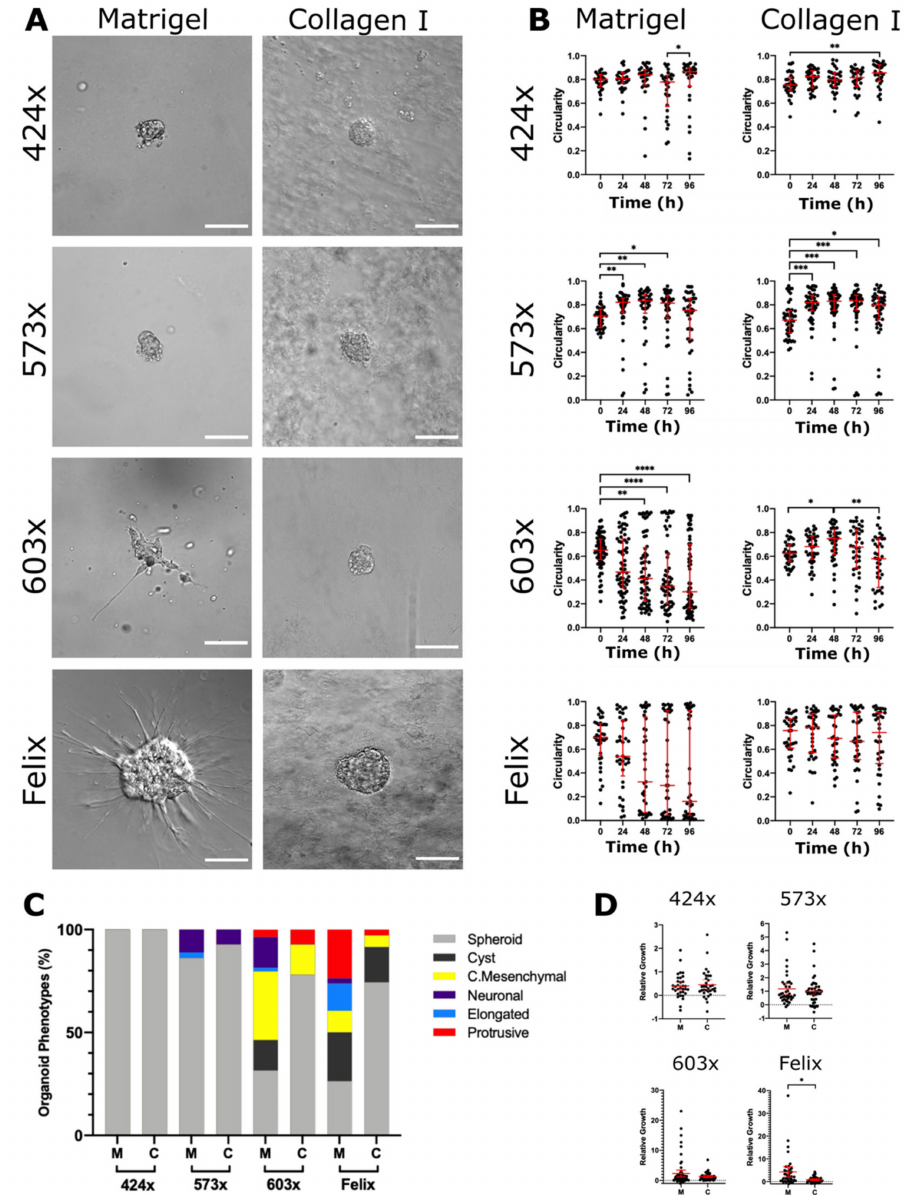
Figure 2. ECM microenvironments modulate the pattern of collective invasion and local dissemination in neuroblastoma cells. ( A ) Representative DIC images of organoids isolated from neuroblastoma PDXs and grown in 3D ECM cultures at 96 h. Based on morphology NB, organoids were classified as non-invasive (spheroid, cyst) or invasive (elongated, collective mesenchymal, neuronal or protrusive). For spheroid and cyst: DIC scale bars = 100 µ M; elongated scale bars = 150 µ M DIC. For other DIC images: scale bars = 200 µ M. ( B ) Organoid circularity was measured at 96 h in Matrigel and collagen (Kruskal–Wallis and Dunn’s post-hoc tests; horizontal bars represent median and interquartile range). ( C ) Bar charts represent phenotype classifications. ( D ) The relative growth of organoids was calculated by dividing the difference in area between 0 h and 96 h by the area at 0 h. Each dot represents the relative growth of one organoid (Matrigel: n = 32 for 424x, n = 41 for 573x, n = 3 for 603x, n = 38 for Felix; collagen: n = 35 for 424x, n = 46 for 573x, n = 40 for 603x, n = 36 for Felix). Error bars indicate the mean ± 95% confidence interval. Asterisks indicate statistical significance obtained using Brown– Forsythe ANOVA with T3 Dunnett post-hoc test (ns, not significant, * p < 0.05, ** p < 0.01, *** p < 0.001, **** p < 0.0001). Scale bars = 100 µ